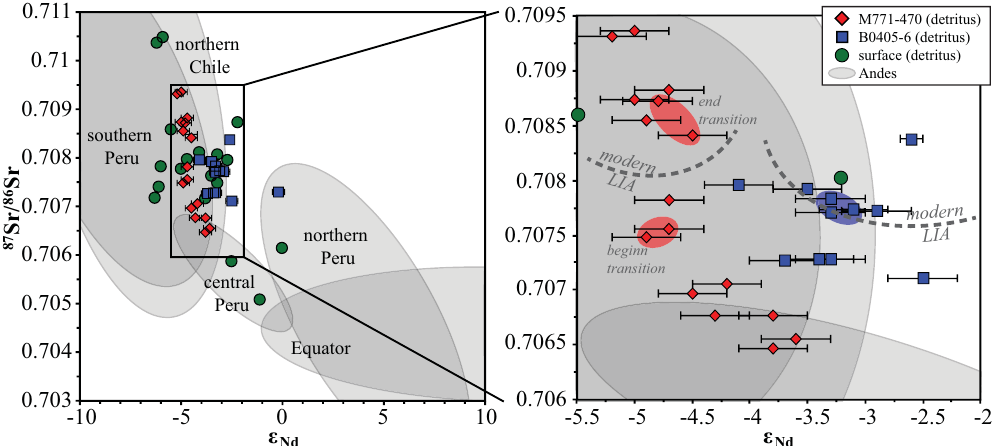
Figure 6. ε Nd detritus versus 87 Sr / 86 Sr detritus for core M771-470 (red diamonds) and B0405-6 (blue squares). Error bars represent 2 σ (sd) external reproducibilities. The green dots are data obtained from surface sediment samples at different sites on the Peruvian shelf. The grey shadings indicate potential sources and provenance end members of the detrital